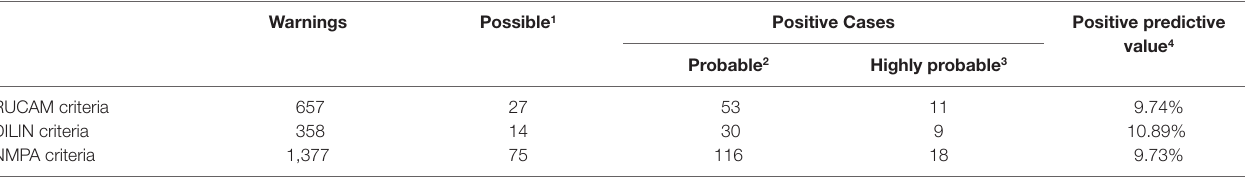
TABLE 1 | Warnings and manual assessment results of the three sets of